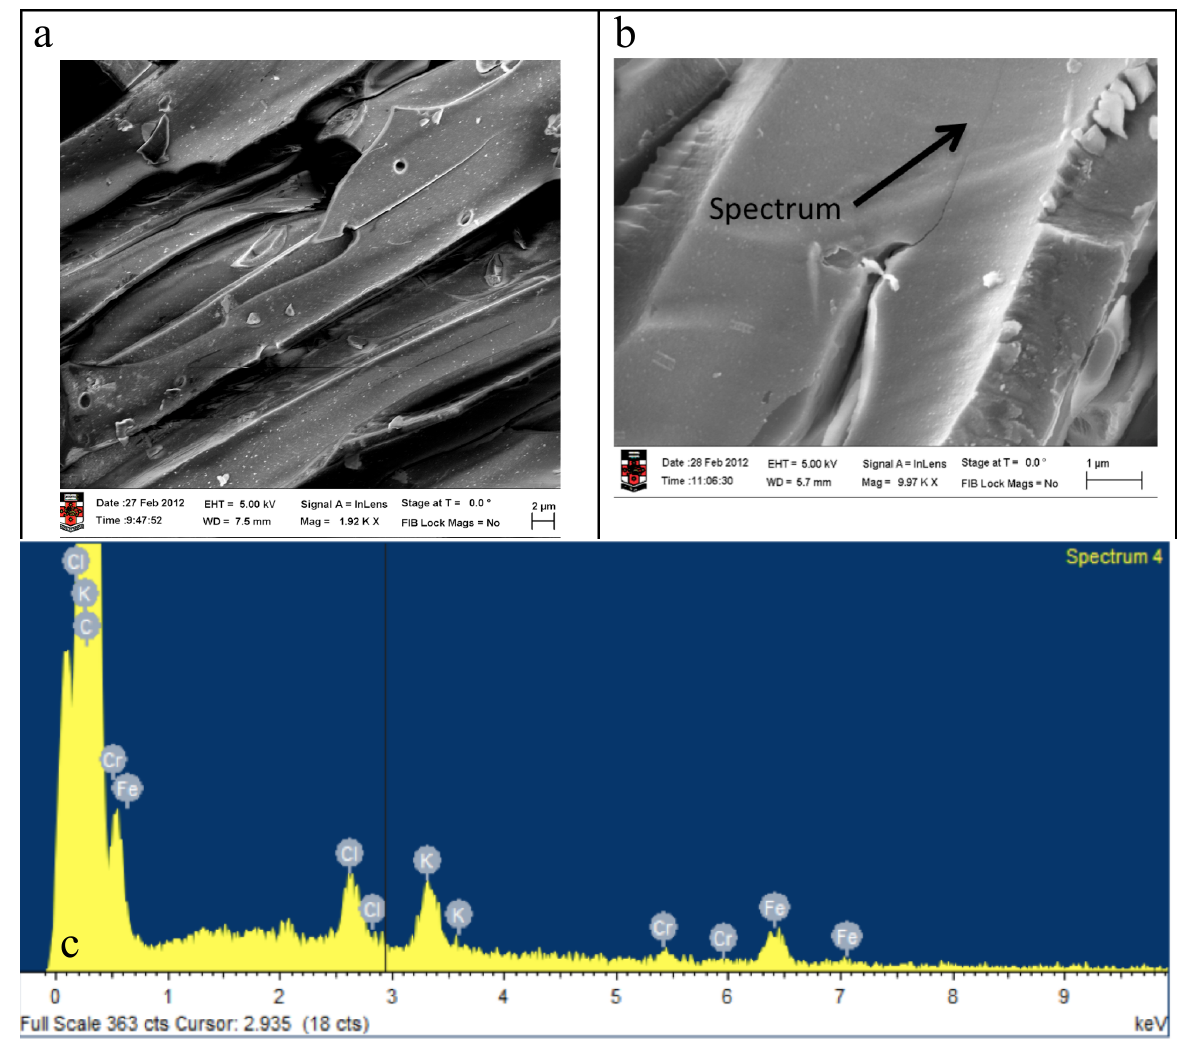
Figure 3. ( a ) SEM image of a surface of a Acacia Saligna biochar where there has been damage on the walls of the biohar ( b ) SEM image of the cracks forming in the carbon matrix of the Acacia Saligna biochar; ( c ) is an EDS analysis of the area shown in ( b ) indicating that there are localised concentrations of Fe-rich and KCl phases on this surface. The damage noted in these images is similar to that reported by [39]. Formation of cracks in the C matrix could be due to the evolution of gas (probably CO 2 ), especially as they occur in regions where there is a high concentration high in Fe and O [40]. TEM examination of the surface of the cycled Saligna biochar revealed the formation of a crack at the end of an Fe-rich mineral phase (Figure 4a–c). Figure 5 shows a TEM image of nanophase Fe/C/O rich particles that were separated from the main biochar particle. The nanophase Fe particles are coated with an amorphous C layer. These structures are similar to those observed by [41] on corroded carbon black